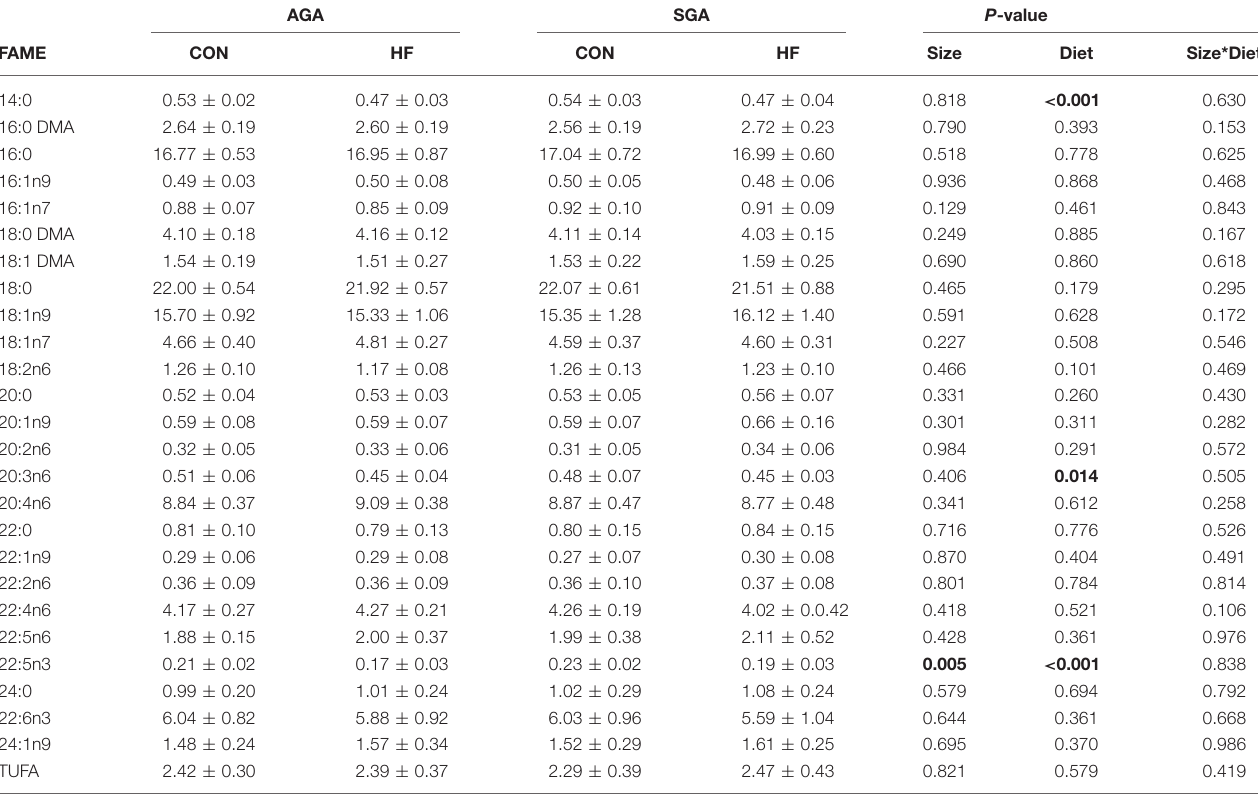
TABLE 6 | Fatty acid composition of piglet hippocampus (%) a,b . AGA